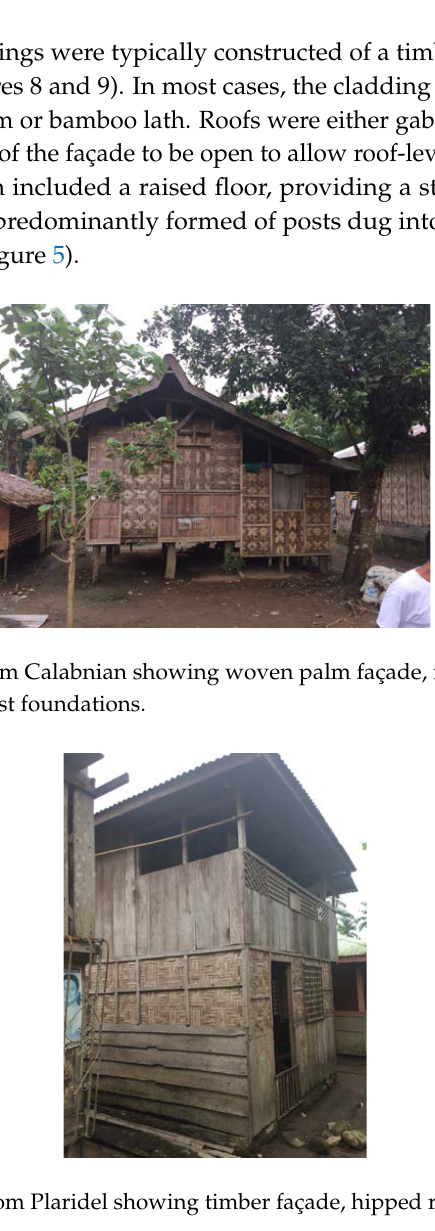
Figure 5. Example house from Plaridel showing timber façade, hipped roof, and concrete slab base.